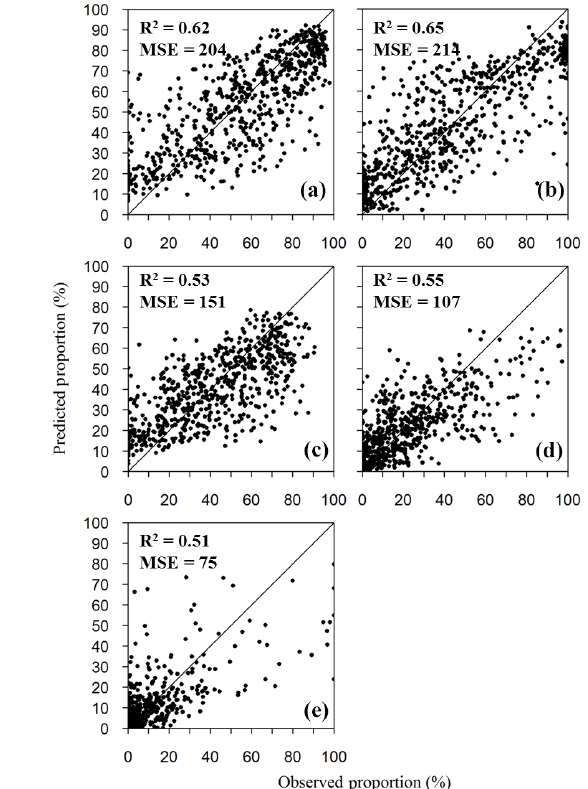
Figure 9. Predicted versus observed proportion of agriculture (a) ; natural vegetation (b) ; crops (c) ; savanna (d) ; and forest (e) for the validation subset ( N = 676). The 1 : 1 line is drawn through the ori-